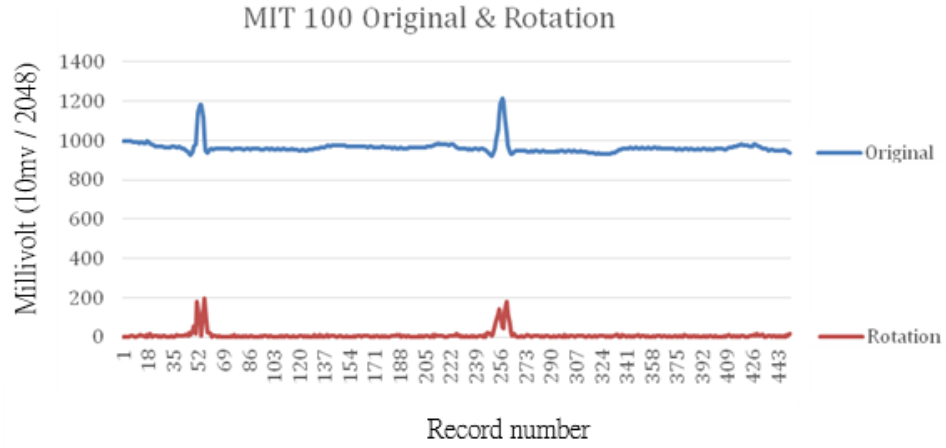
Figure 5. MIT/BIH Arrhythmia Database recording 100 ECG volumes and rotated delta volumes.